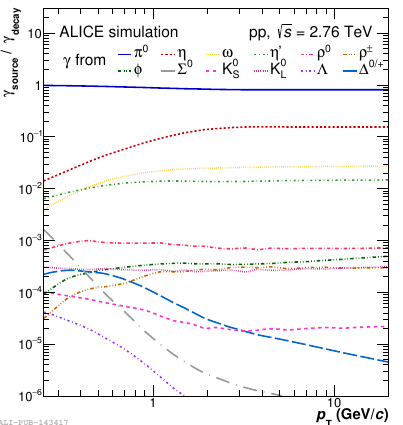
Figure 1. Relative contribution of di ff erent hadrons into the decay photon spectrum in pp collisions at √ s = 2 . 76 TeV. Hadron spectra are measured with ALICE experiment and then used to estimate decay photon spectrum